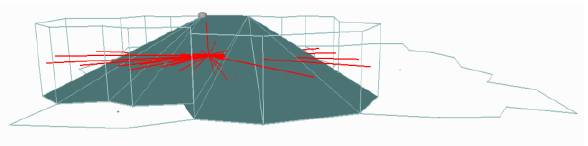
Fig. 11. Example of Line Extrusion technique